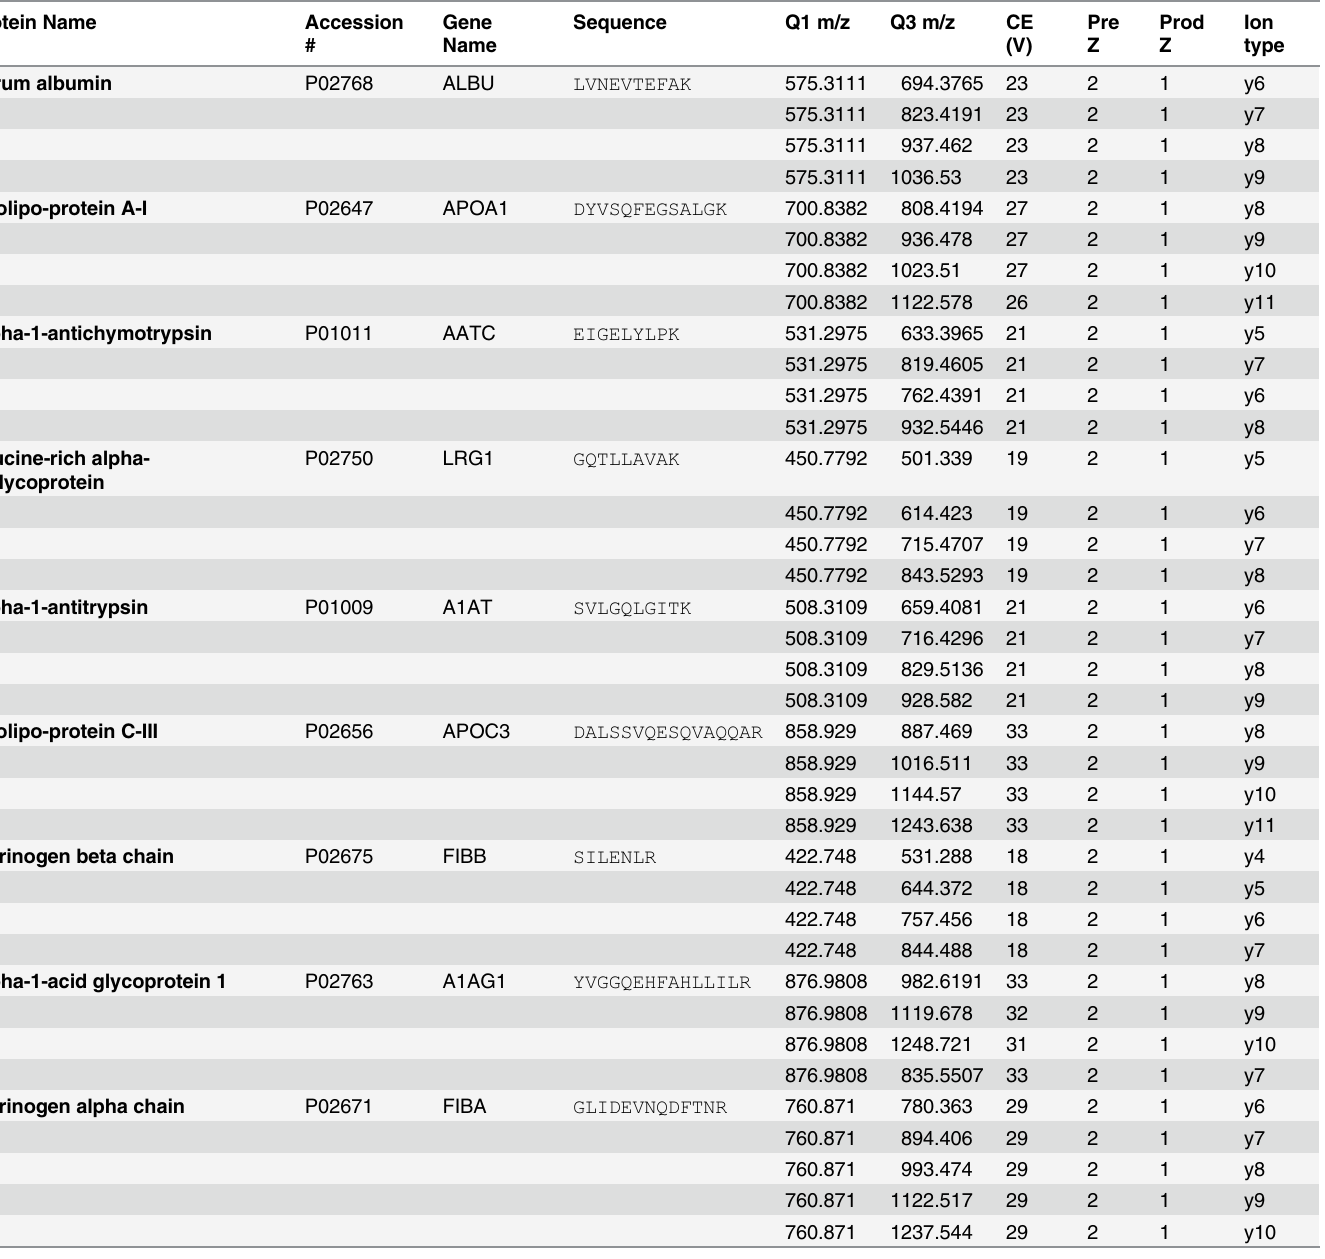
Table 4. SID-SRM-MS assays for candidate plasma